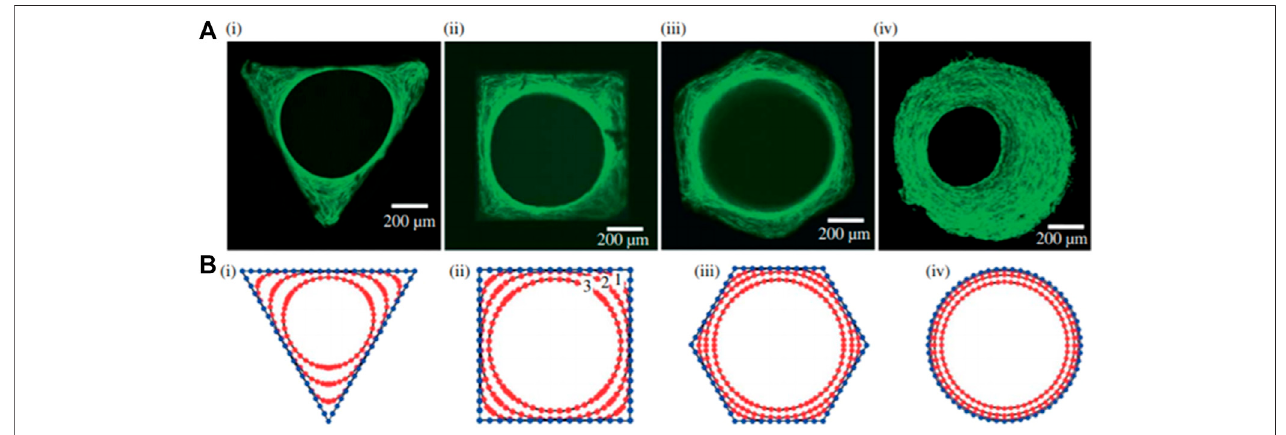
FIGURE 6 | A study on cell interaction and cell-growth concentration as pore shape changes. Reproduced from Rumpler et al. (2008).